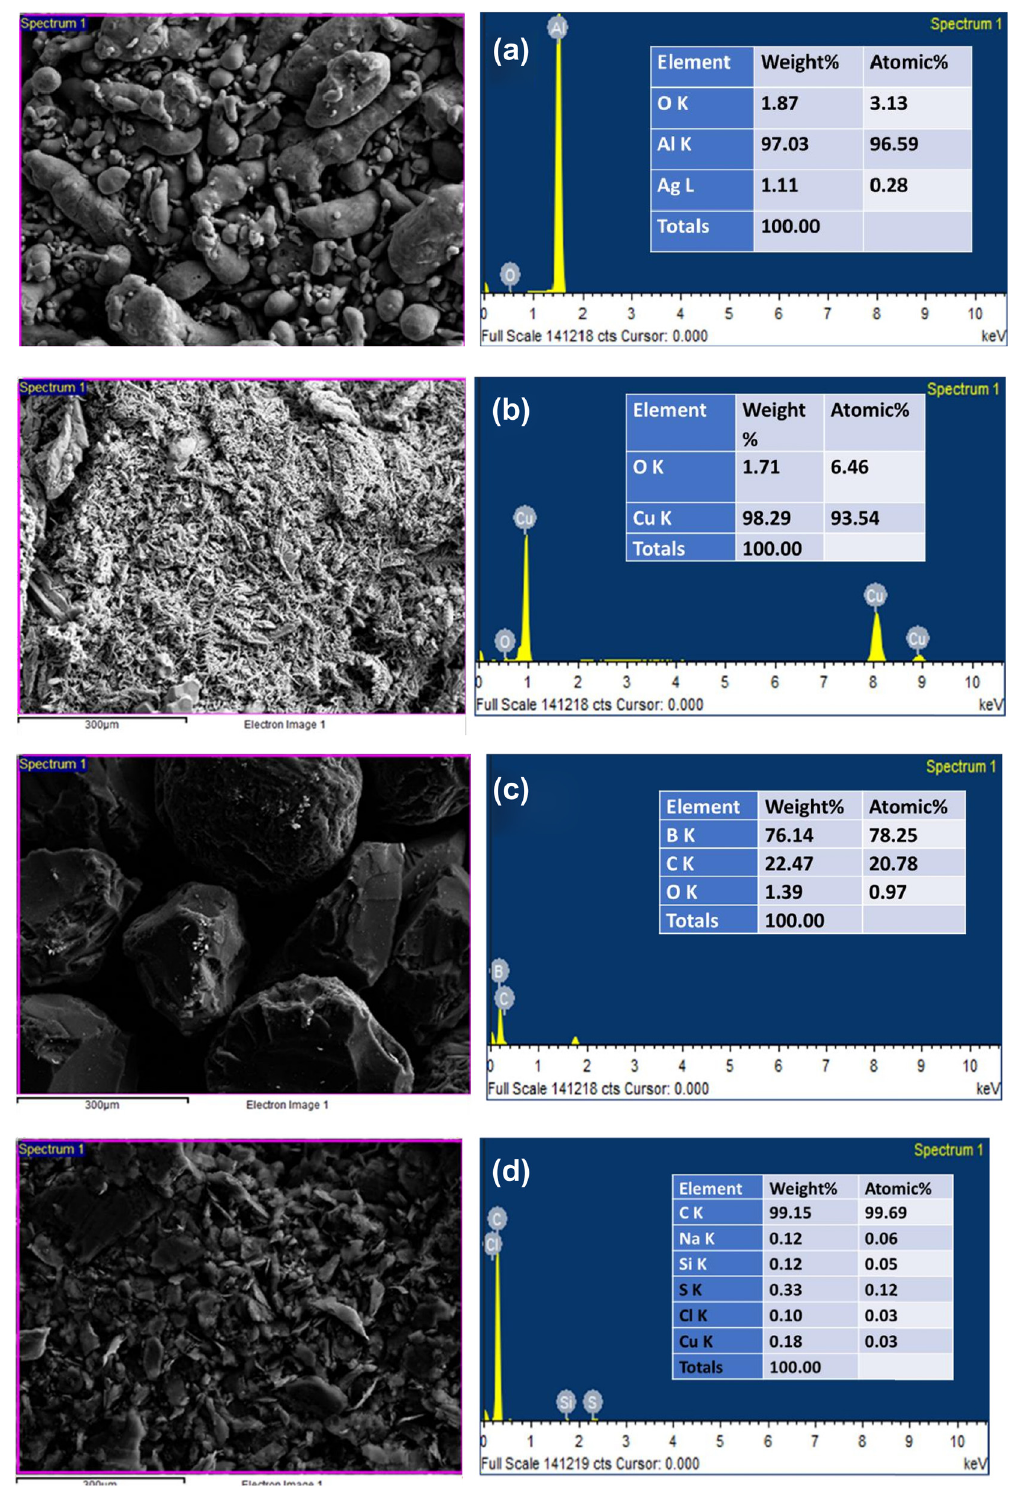
Figure 2: ( a ) EDS analysis of the Al powder and its SEM image. ( b ) EDS analysis of the Cu powder and its weight percentage. ( c ) EDS analysis of B 4 C particles and its weight percentage. ( d ) EDS analysis of Gr powder and its